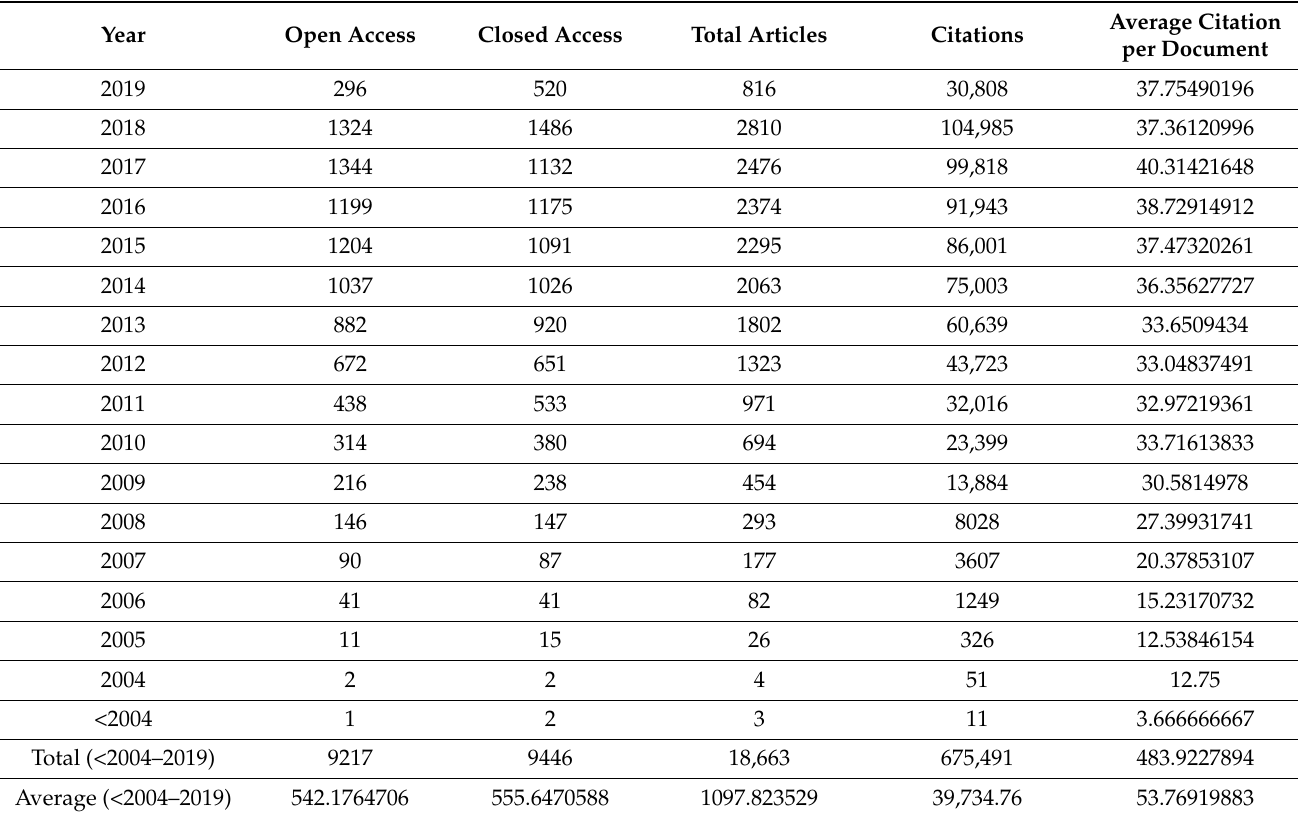
Table 3. Number of published articles and citations per year